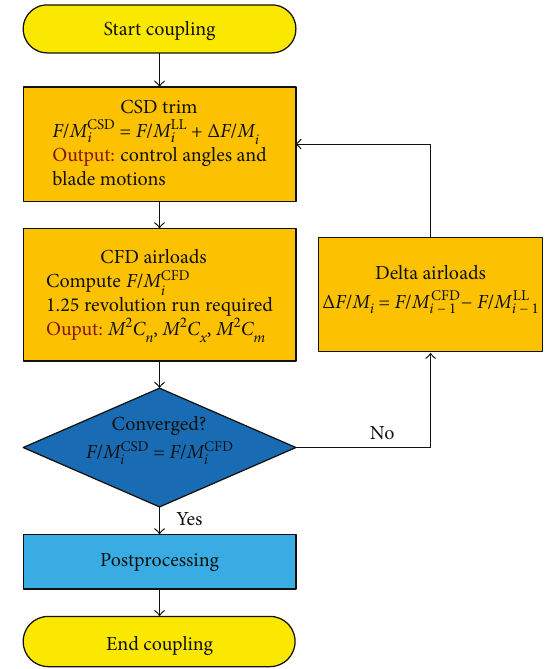
Figure 3: Flow diagrams for a loose CFD/CSD coupling